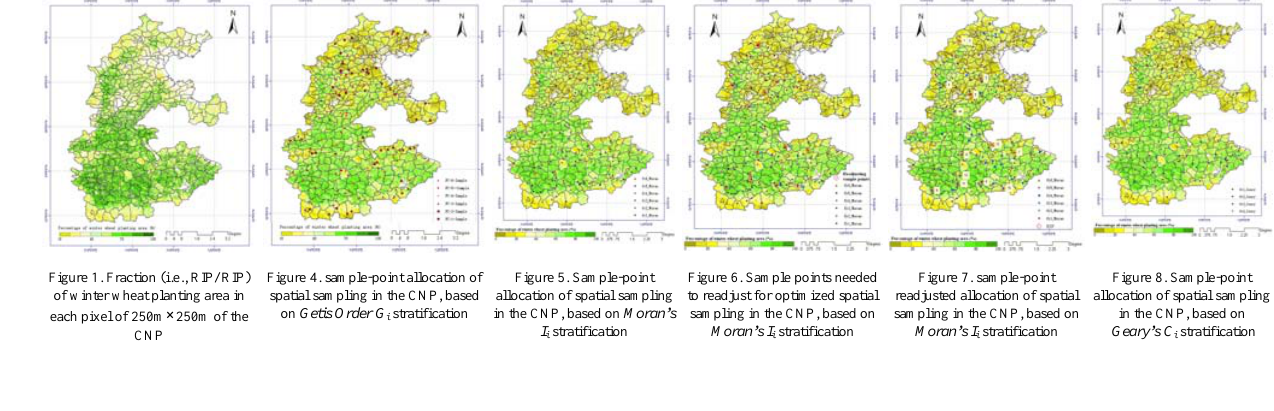
Figure 5. Sample-point allocation of spatial sampling in the CNP, based on Moran’s I i stratification